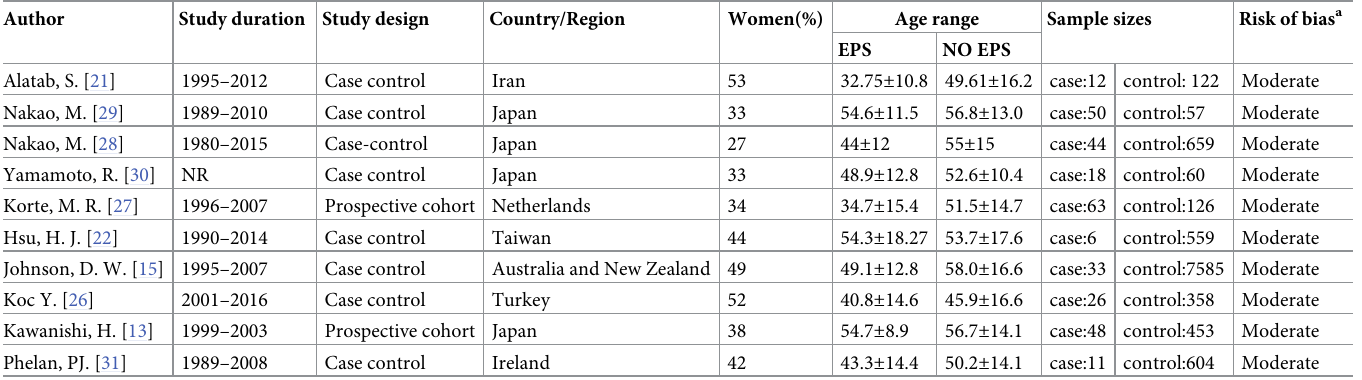
Table 1. Basic characteristics of all studies in this meta-analysis.